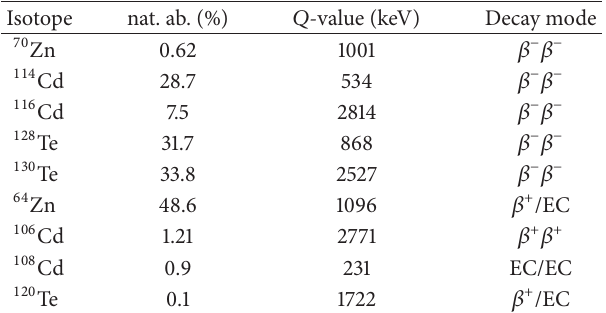
Table 1: List of 0 ] 𝛽𝛽 -decay isotopes in CdZnTe with their 𝑄 -values and natural